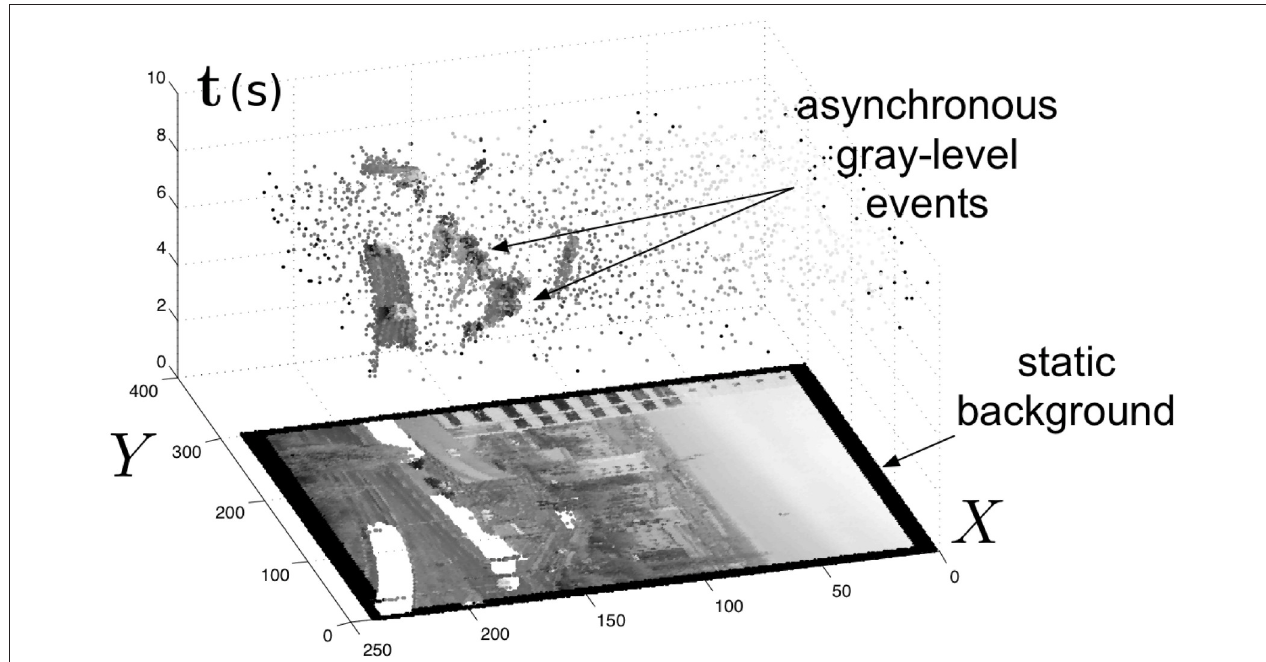
FIGURE 2 | The spatio-temporal space of imaging events: Static objects and scene background are acquired first. Then, dynamic objects trigger asynchronous gray-level pixel-events after each change. Frames are absent from this acquisition process.